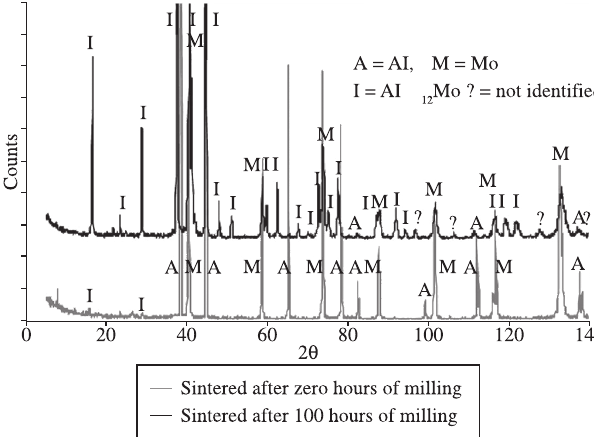
Figure 10. X ray diffraction of sintered specimens as a function of the mill- ing time.